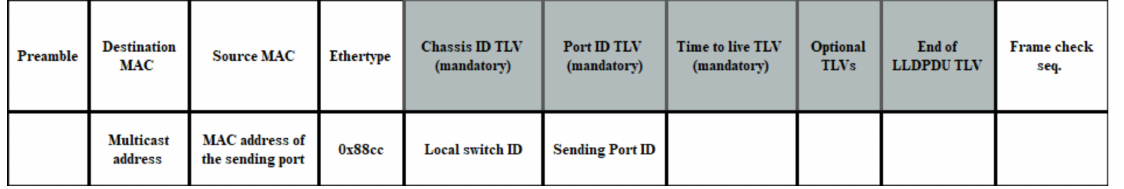
Figure 5. LLDP frame format used in OFDP